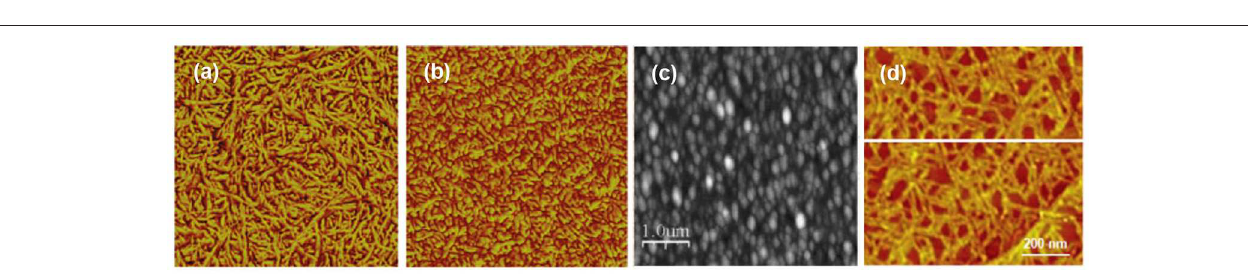
FIGURE 2 | AFM images of cellulose films spin coated from a solution of (a) NMMO/water, 1 × 1 µ m 2 scan (Reproduced from Aulin et al., 2009 with permission from American Chemical Society), (b) DMAc/LiCl, 1 × 1 µ m 2 (Reproduced from Aulin et al., 2009 with permission from American Chemical Society) and (c) thiourea/NaOH/water, 5 × 5 µ m 2 scan (Reproduced from Yan et al., 2008 with permission from John Wiley & Sons, 2008); (d) individual cellulose molecules cast from a CED solution, 1 × 1 µ m 2 scan (copyright Elsevier 2007) (Yokota et al.,